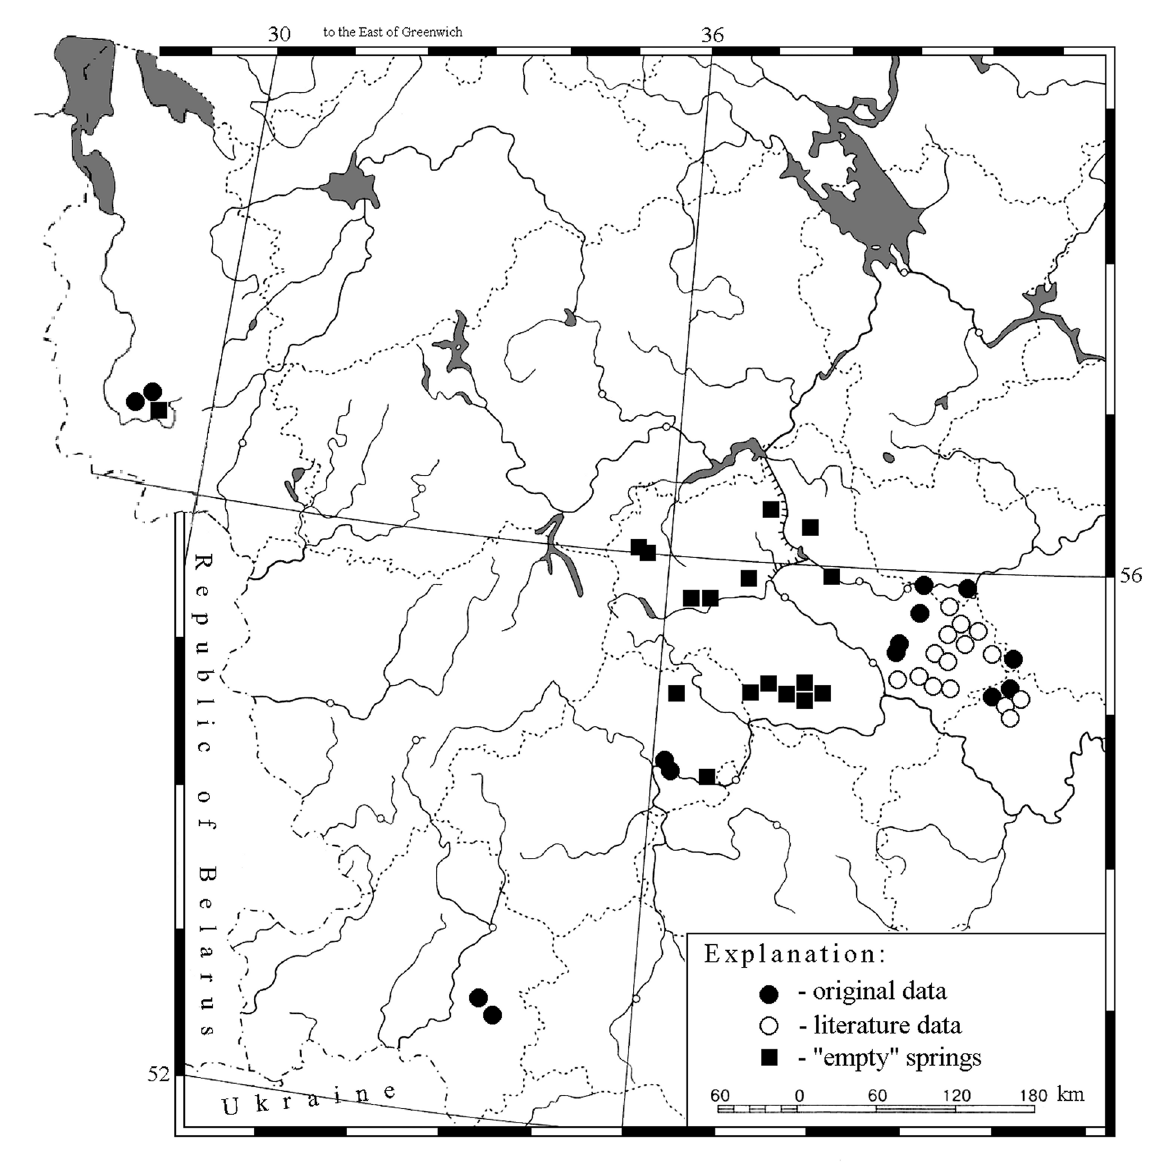
Fig. 1. Map indicating the geographic distribution of Synurella ambulans (F. Müller, 1846) in western Russia. Legend: “empty” springs display undisturbed springs with a rich crenophilous fauna without S. ambulans. Literature data: Borutzky (1929), Chertoprud (2006a, 2006b). Source: Blank Mapping Tools, Moscow